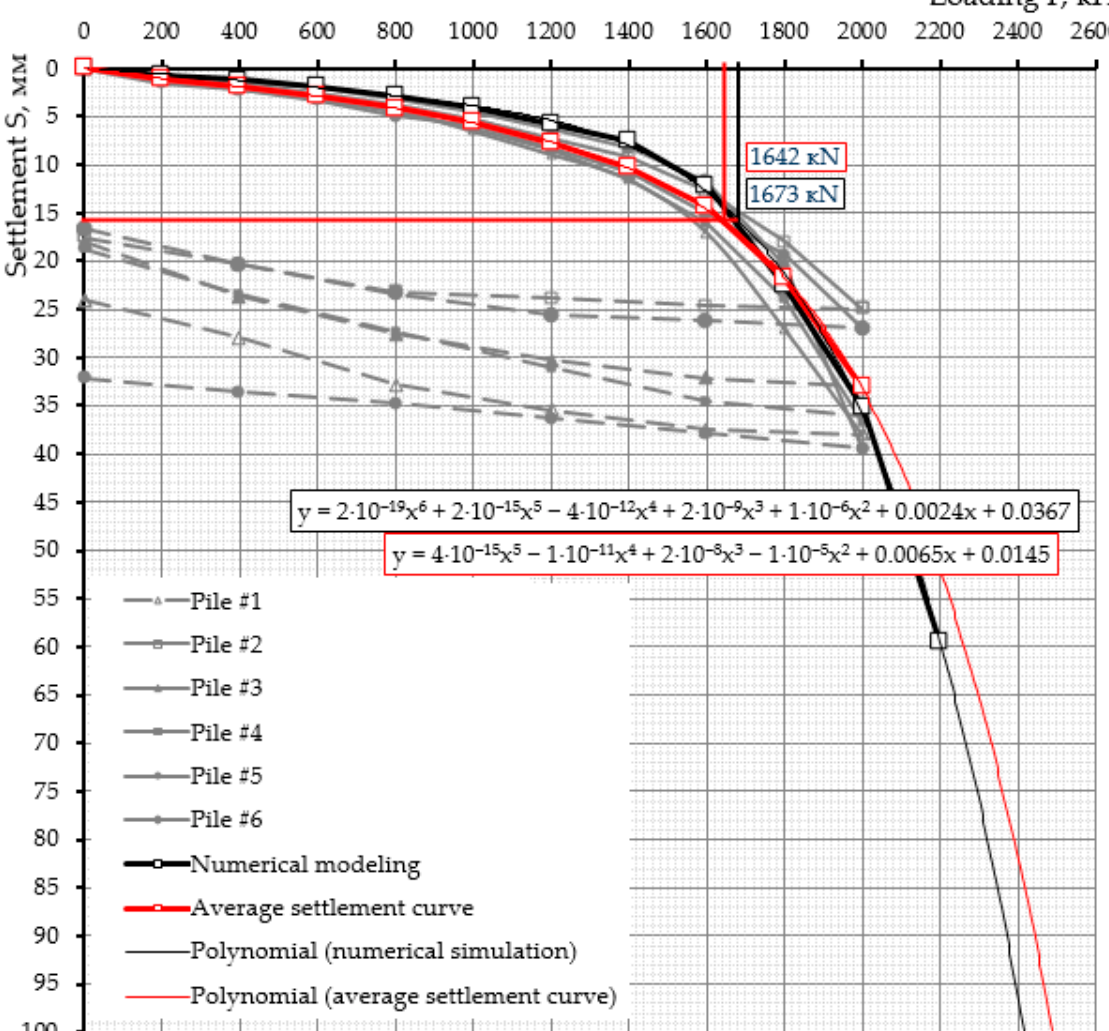
Figure 14. Comparison of “load–settlement” curves obtained by field tests and numerical modeling.